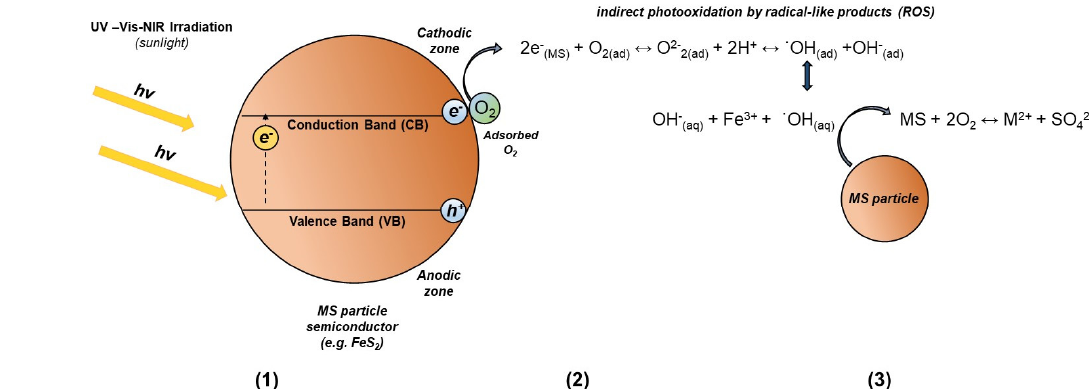
Figure 5. Scheme of photodecomposition mechanism of semiconductor (binary semiconductor MS) in electrolytic medium by: charge carriers ( A ) and ROS or RSS ( B ). Stages: (1) photoactivation of SC particles, (2) charge carriers and radicals generation, (3) photodecomposition of SC particles by charge carriers and ROS or RSS.